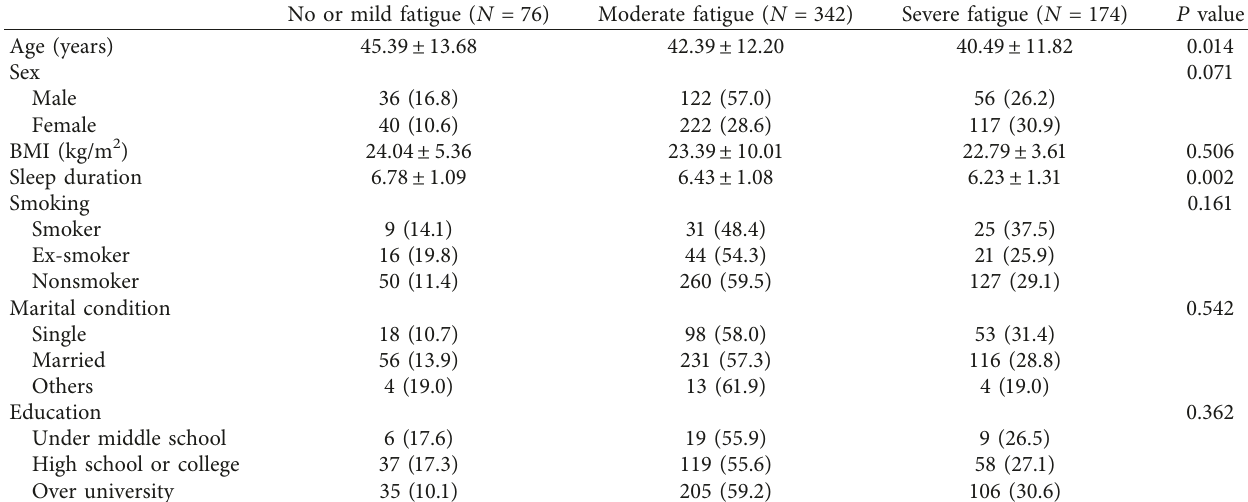
Table 1: Baseline characteristics of the study population.